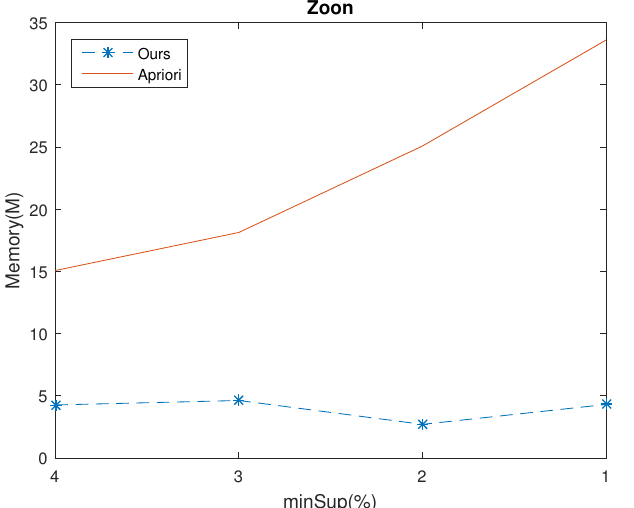
Figure 11. Memory usage of the two algorithms in Zoon dataset for various minSup values.